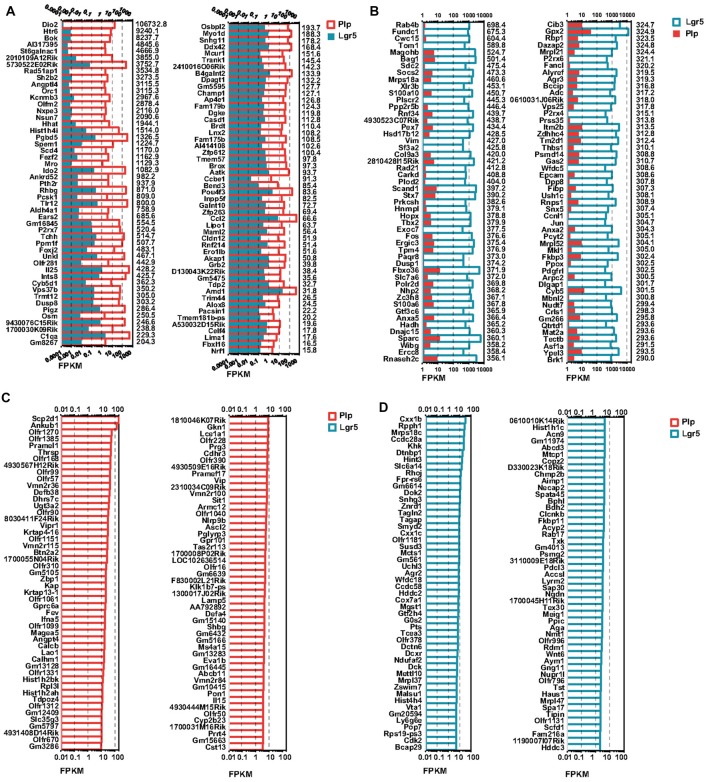
Differentially and uniquely expressed genes in Lgr5+ SCs and Plp1+ SCs. (A) The top 100 most differentially expressed genes in Plp1+ SCs. The numerical values on the right side of each panel represent the fold difference in expression for Plp1+ SCs vs. Lgr5+ SCs. (B) The top 100 most differentially expressed genes in Lgr5+ SCs. The numerical values on the right side of each panel represent the fold difference in expression for Lgr5+ SCs vs. Plp1+ SCs. (C) The 100 uniquely expressed genes in Plp1+ SCs. The numerical values on the right side of each panel represent the fold difference in expression for Plp1+ SCs vs. Lgr5+ SCs. (D) The 100 uniquely expressed genes in Lgr5+ SCs. The numerical values on the right side of each panel represent the fold difference in expression for Lgr5+ SCs vs. Plp1+ SCs. The length of the bar after each gene represents its FPKM value.